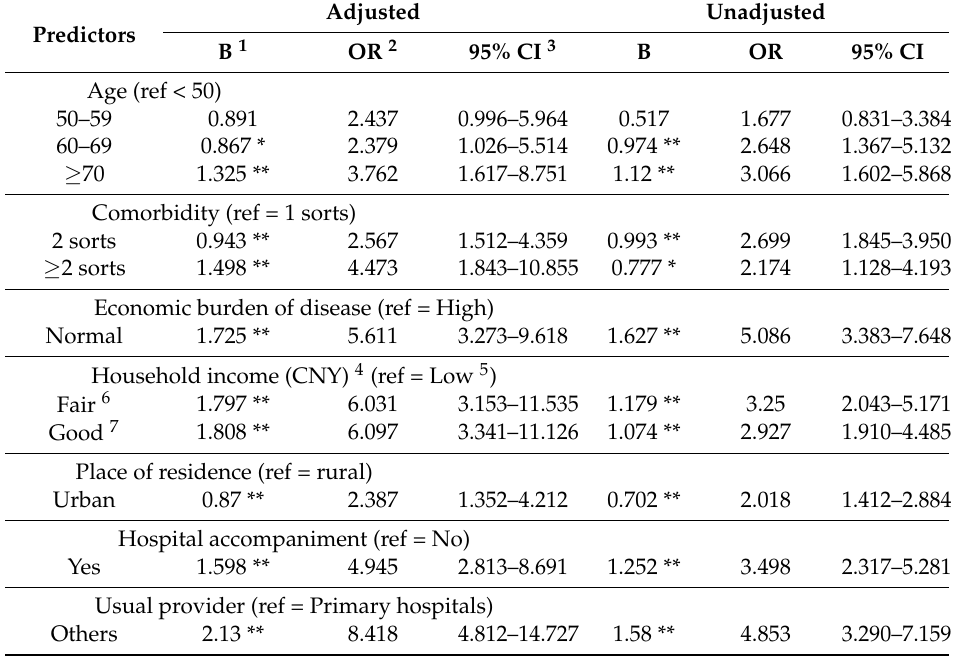
Table 3. Results of multivariate logistic regression analyses examining factors associated with regular clinical visits among hypertension and diabetes